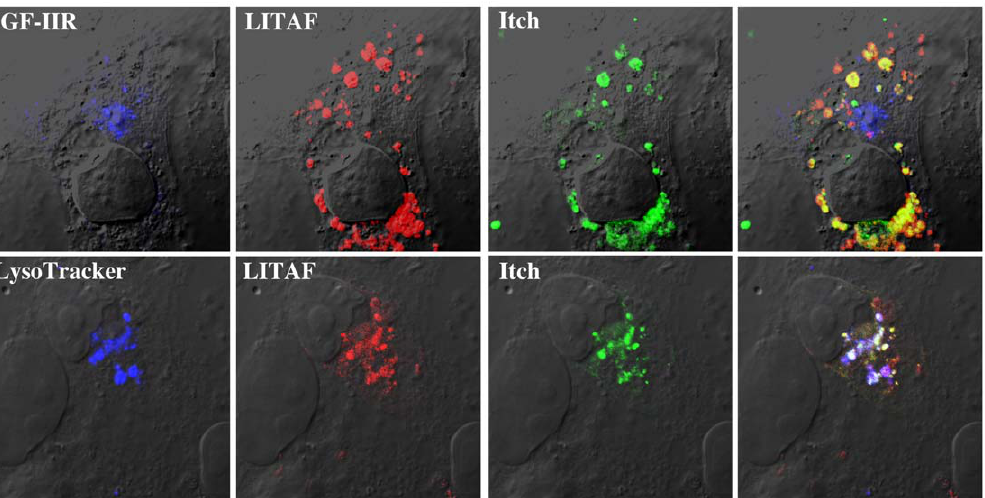
Figure 3. LITAF changes the cellular localization of Itch. FLAG-LITAF was transiently co-transfected into BGMK cells with GFP-Itch. Sixteen hours post-transfection, cells were probed with LysoTracker (blue) and fixed. LITAF was detected using anti-FLAG antibodies (red) while the trans- Golgi network was identified using anti-IGF-IIR antibodies (blue). GFP-Itch is shown in green. Cells were visualized using DIC.